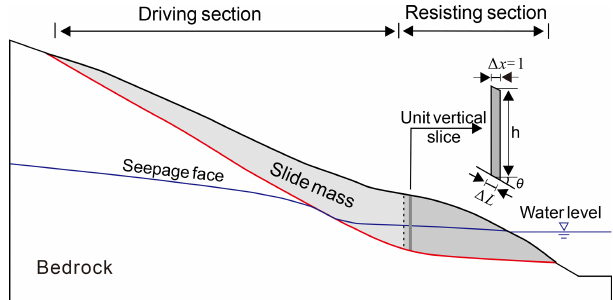
Figure 3. Driving–resisting model for reservoir